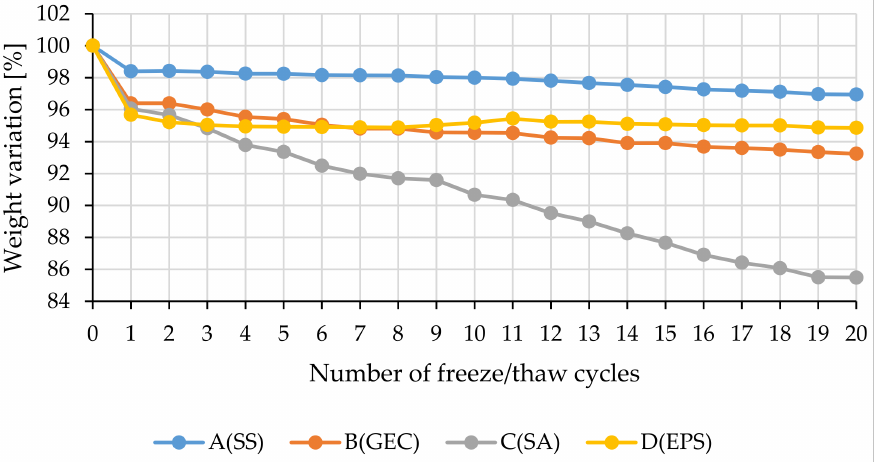
Figure 1. Weight variation along the freeze/thaw